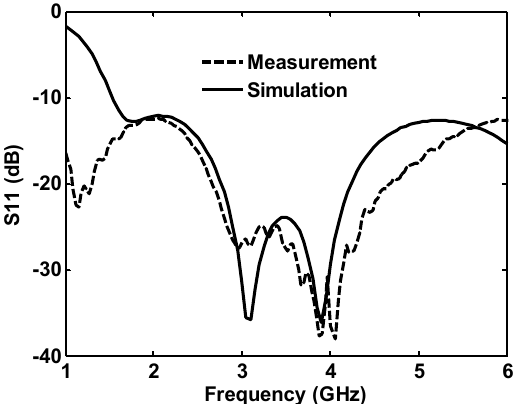
Figure 16. Measured and simulated reflection coefficient for the single-port antenna.